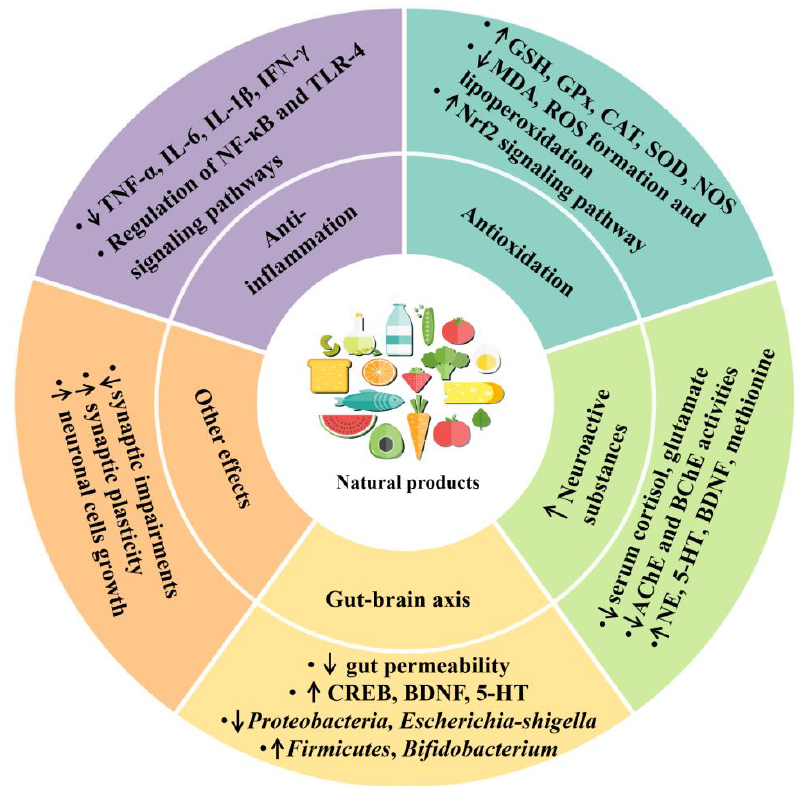
Figure 2. The effects and mechanisms of dietary natural products on anxiety. ↑ represents increase, and ↓ represents decrease. AChE, acetylcholinesterase; BChE, butyrylcholinesterase; BDNF, brain-derived neurotrophic factor; CAT, catalase; CREB, cyclic adenosine monophosphate response element-binding protein; GPx, glutathione peroxidase; GSH, glutathione; 5-HT, serotonin; IFN- γ, interferon-gamma; IL, interleukin; MDA, malondialdehyde; NE, norepinephrine; NF- κB, nuclear factor kappa-B; NOS, nitric oxide synthase; Nrf2, nuclear erythroid related factor 2; ROS, reactive oxygen species; SOD, superoxide dismutase; TLR-4, Toll-like receptor-4; TNF- α, tumor necrosis factor - α.